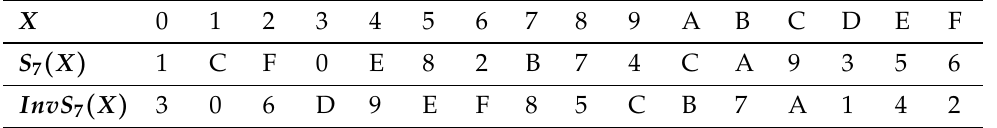
Table 8. Eighth S-Box of Serpent defined as S 7 ( X )